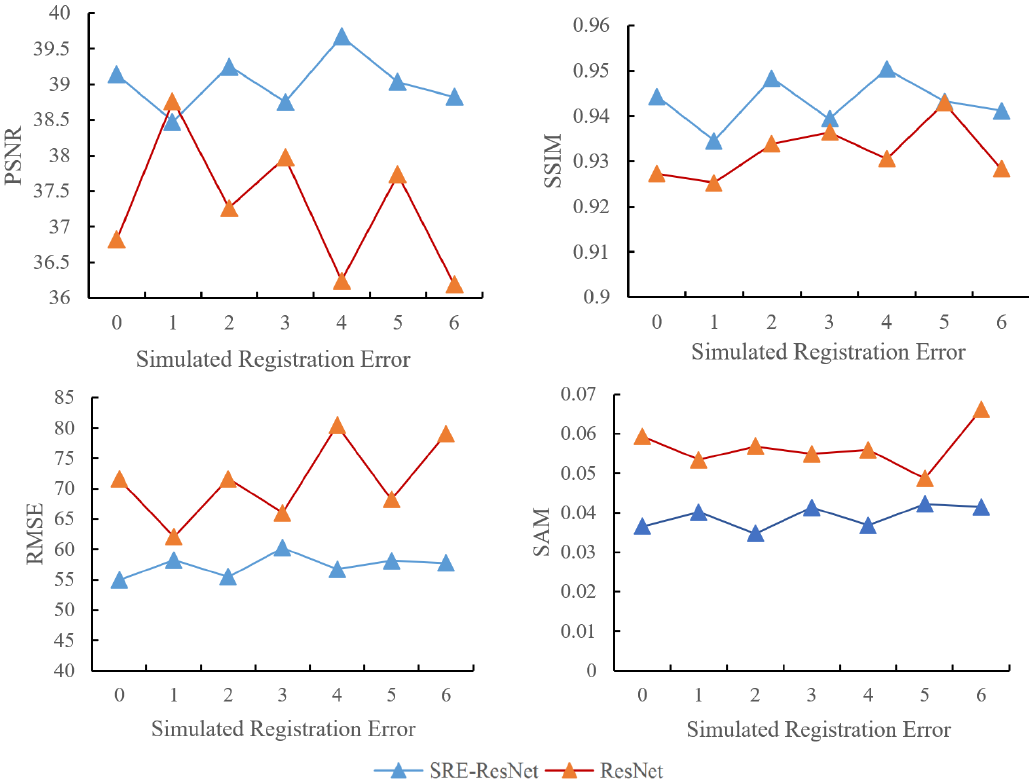
Figure 9. Quantitative fusion result comparison between SRE-ResNet and ResNet for Dataset I.